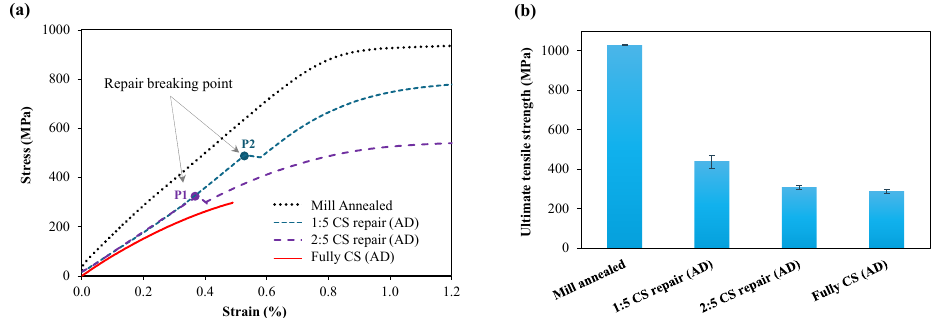
Figure A1. A comparison of tensile properties among mill annealed Ti6Al4V, fully CS Ti6Al4V, and CS repairs (repair ratios 2:5 and 1:5) in AD condition: ( a ) strain-strain curves, ( b ) UTS values.